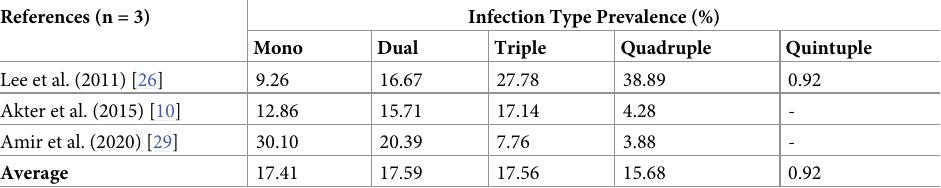
Table 3. The infection type prevalence in selected